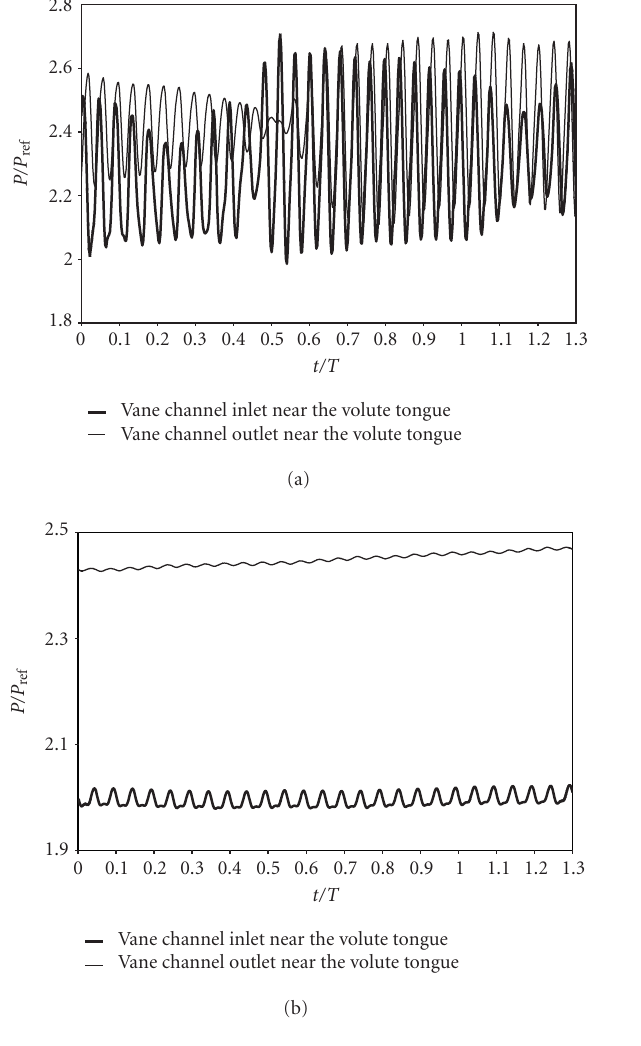
Figure 3: Temperal variation of the static pressure at the inlet and exit of the vane channel for the compressor with (a) vaneless and (b) vaned di ff users.